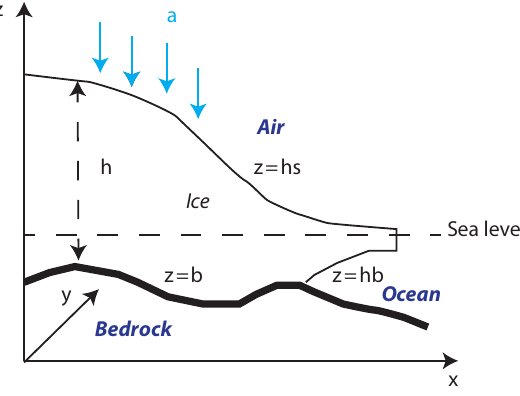
Figure 1. General Cartesian geometry of the f.ETISh